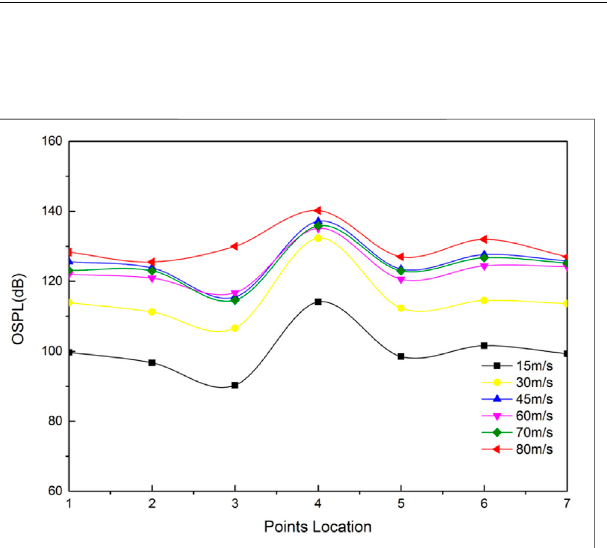
FIGURE 4 | The SPL curve and contour at different frequencies/dB: (A) The SPL curve of P2; (b) the SPL curve of P5; (C) the sound pressure contour at different frequencies.